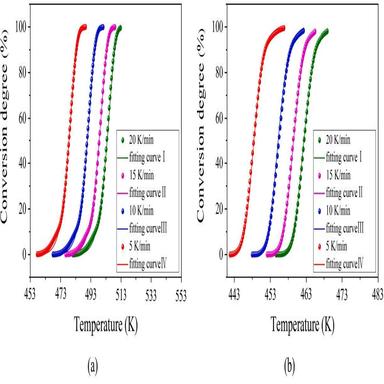
Experimental data and curve fitting results obtained through non-linear regression investigation for the decomposition of compounds 2 and 3.